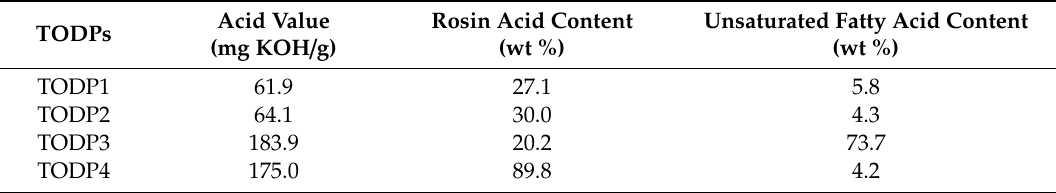
Table 3. Chemical composition of tall oil distillation products